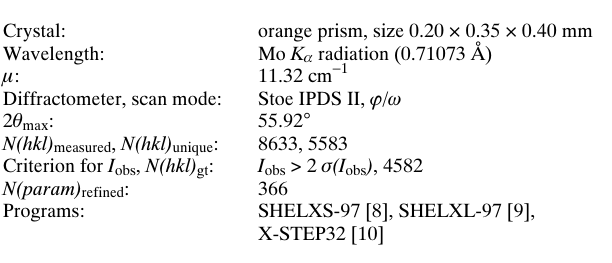
Table 1. Data collection and